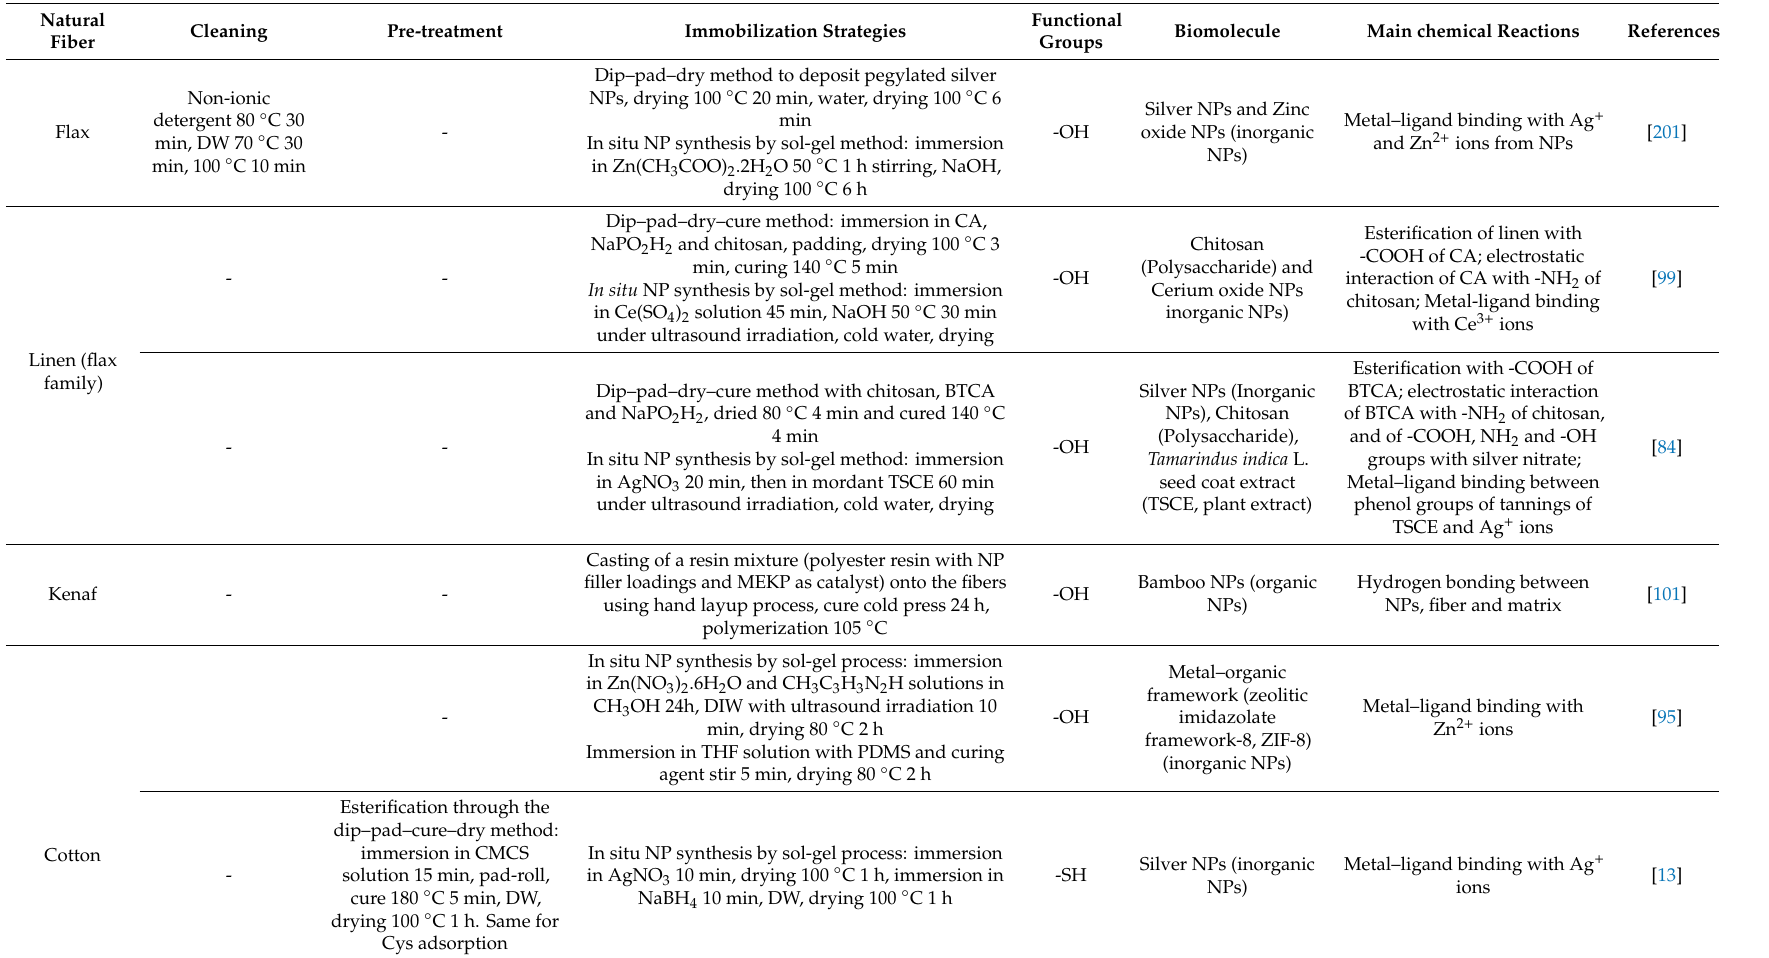
Table 5. Recent trends on biomolecule immobilization strategies onto natural